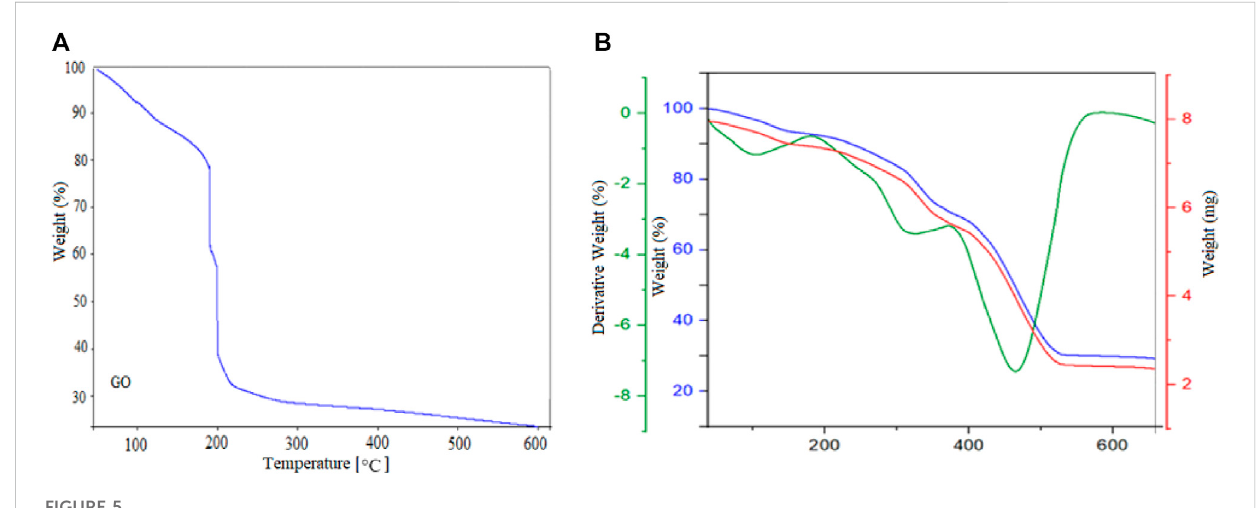
FIGURE 5 TGA curves of (A) GO and (B) Cu-PTC@GO.